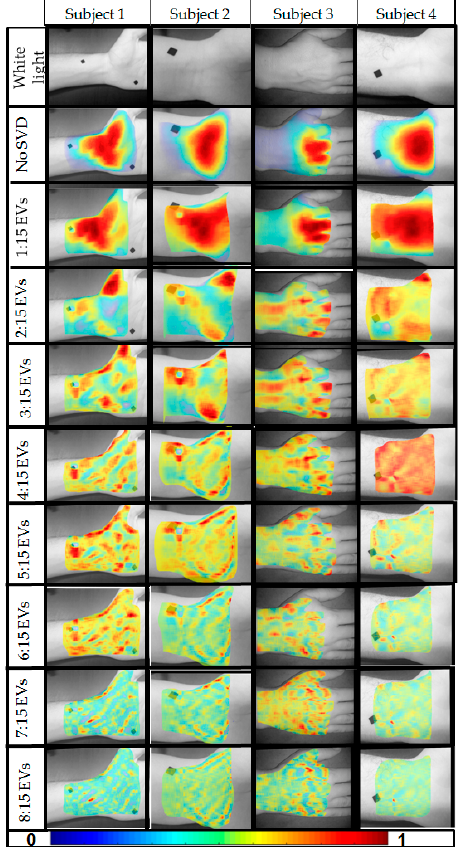
Figure 7. Reconstructed diffuse reflectance images (at 690 nm) under rest conditions, as obtained from four healthy subjects. The first row shows the white light image (in gray scale) of the region of interest that was imaged. The second row shows the coregistered reconstructed images when no single value decomposition (SVD) was applied. The 3rd–10th rows are coregistered reconstructed images employing SVD and eliminating one lower EV sequentially across the